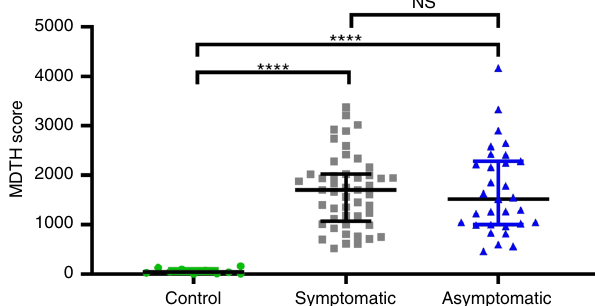
Fig. 4 MDTH scores are similar in symptomatic or asymptomatic cCMV infection. Transcripts that were differentially expressed in either symptomatic or asymptomatic cCMV infection (3756 transcripts) were used to calculate the molecular distance to health (MDTH) scores for healthy controls ( n = 10), symptomatic ( n = 49), and asymptomatic ( n = 31) cCMV infection. Data are represented as individual MDTH scores per patient (green circles: healthy controls; gray squares: symptomatic cCMV infection; blue triangles: asymptomatic cCMV infection) along with medians and 25 – 75% interquartile ranges. Groups comparisons were performed using Kruskal – Wallis with Dunn ’ s test for multiple comparisons; **** two tailed p < 0.0001; NS non-signi fi cant.